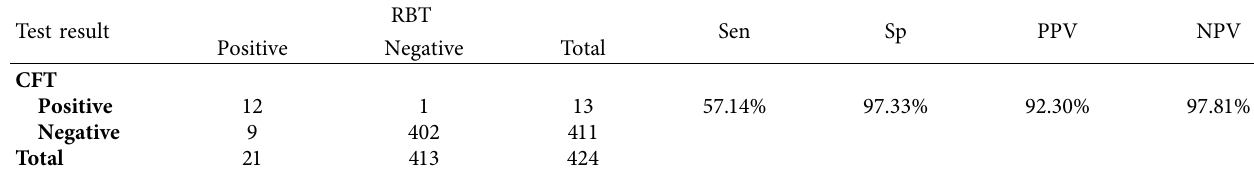
Table 4: Sensitivity and specifcity of the CFT as shown by the